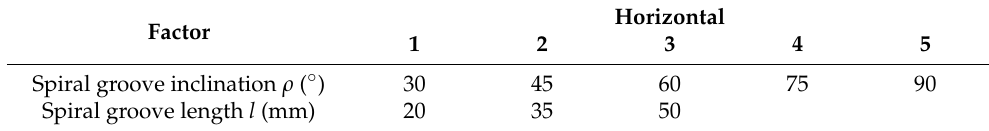
Table 2. Two-factor test factor and level table.